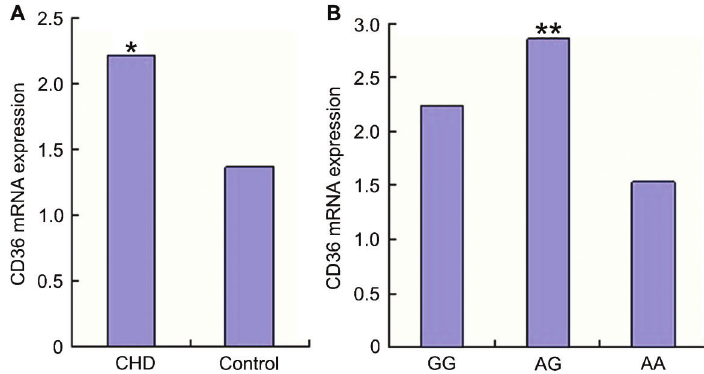
Figure 4. CD36 mRNA expression of coronary artery heart disease (CHD) patients and healthy controls. A , The expression of CD36 mRNA in CHD patients (2.21±1.55) was significantly higher than that of healthy controls (1.36±1.01; P , 0.001). B , There were significant differences in the CD36 mRNA expression in CHD patients with different genotypes of rs1761667 (**P=0.018), and the CD36 mRNA expression in CHD patients with AG genotype (2.86±1.70) were remarkably higher than those with AA genotype (1.53±0.78; P=0.005). No significant differences were observed in CD36 mRNA expression of CHD patients with GG (2.24±1.72) and AG or AA genotype (P=0.173, P=0.125, respectively). The t -test was used for statistical analyses.